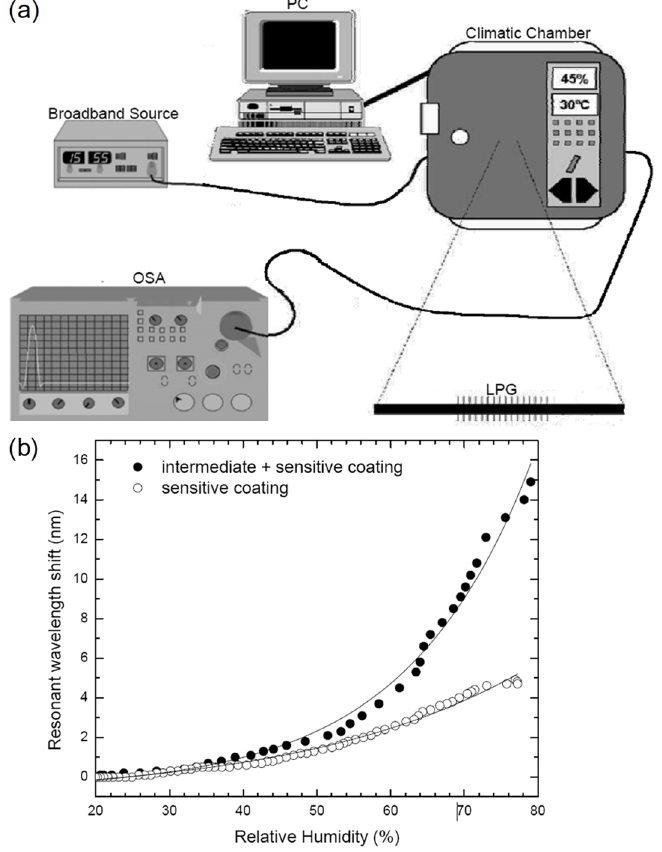
Figure 13. Point sensor. ( a ) Experimental setup. ( b ) Wavelength shift as a function of RH for two coating strategies. Adapted with permission from ref. [55]. Copyright 2009 MDPI